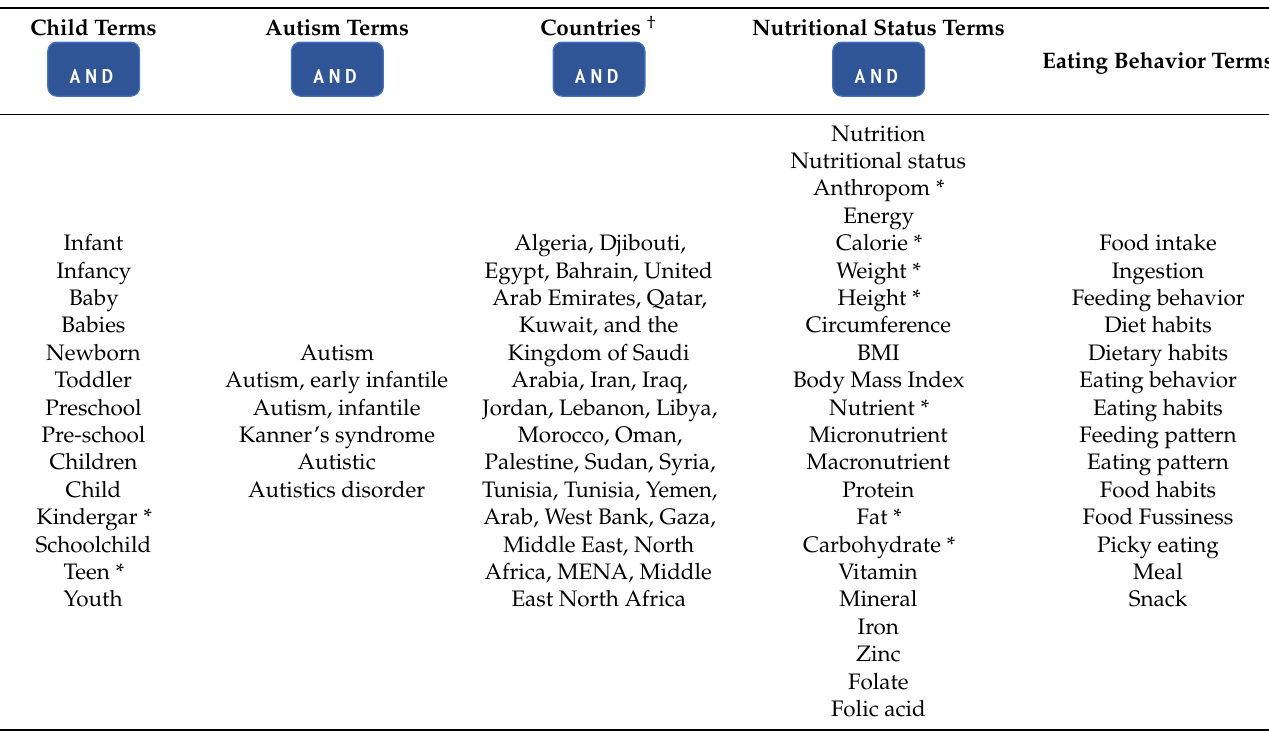
Table 1. Search strategy.